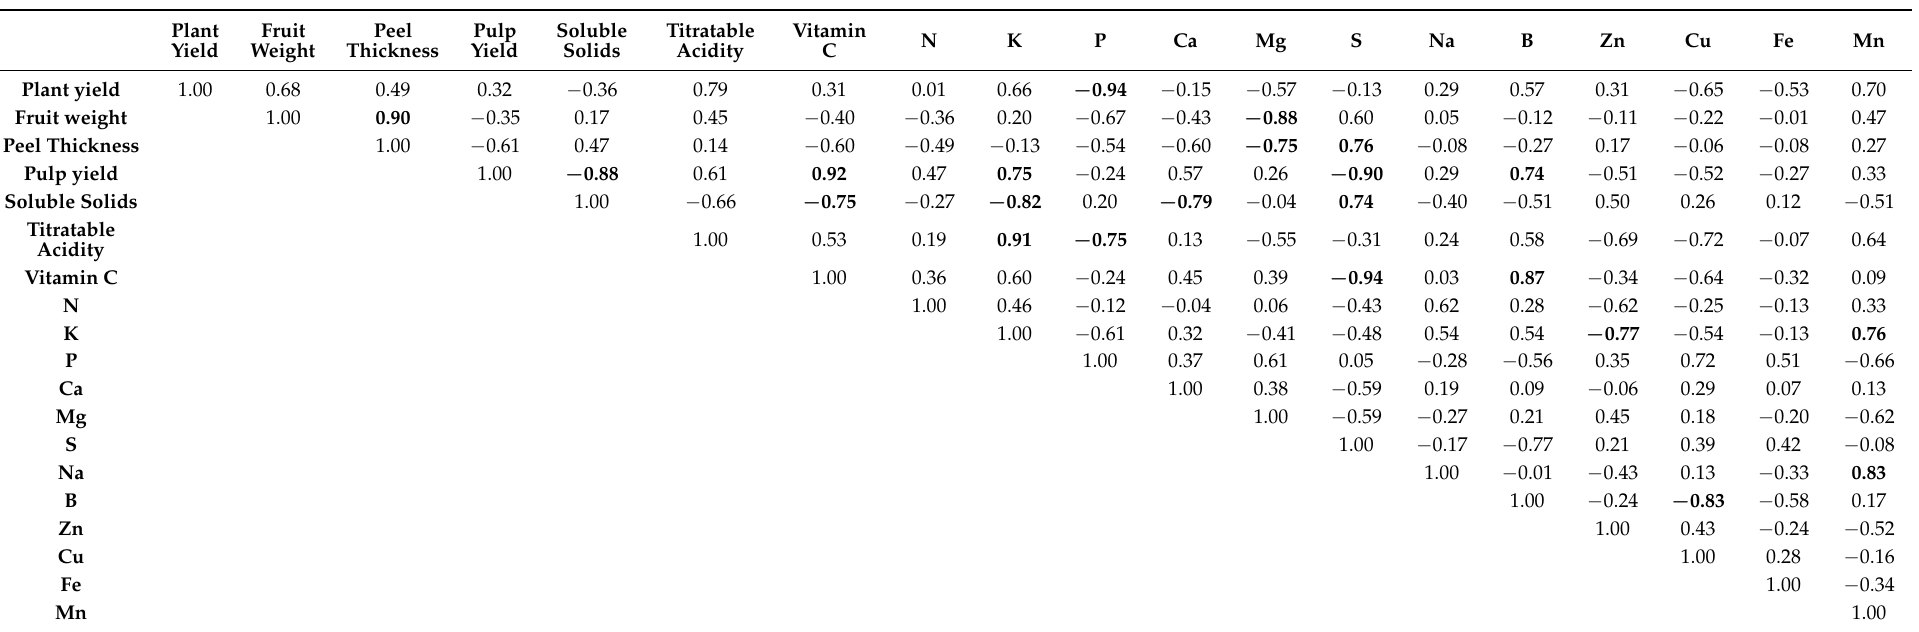
Table 3. Pearson correlation between fruit quality traits and mineral content of passion fruit germplasm. Bold represents statistical significance at